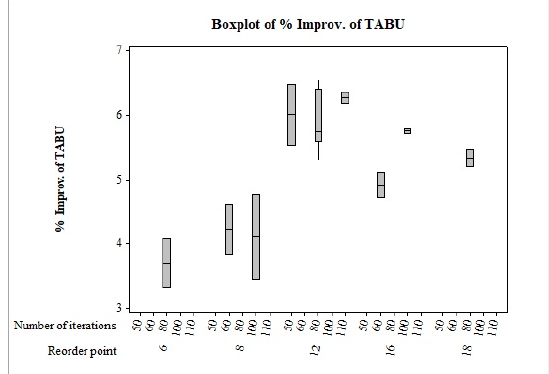
Fig. 11. Result of box plot for % improvement of tabu over the current practice (OUL) according to the parameters setting of the tabu search